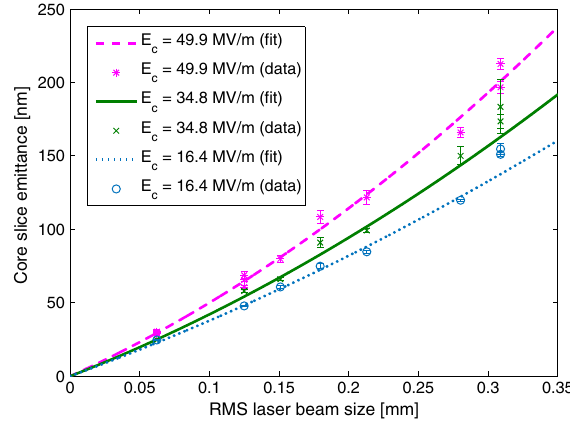
FIG. 3. Core slice emittance as a function of beam size for three different fields on the cathode. The nonlinear effect was reduced for lower fields and the normalized intrinsic emittance varied as expected from theory.